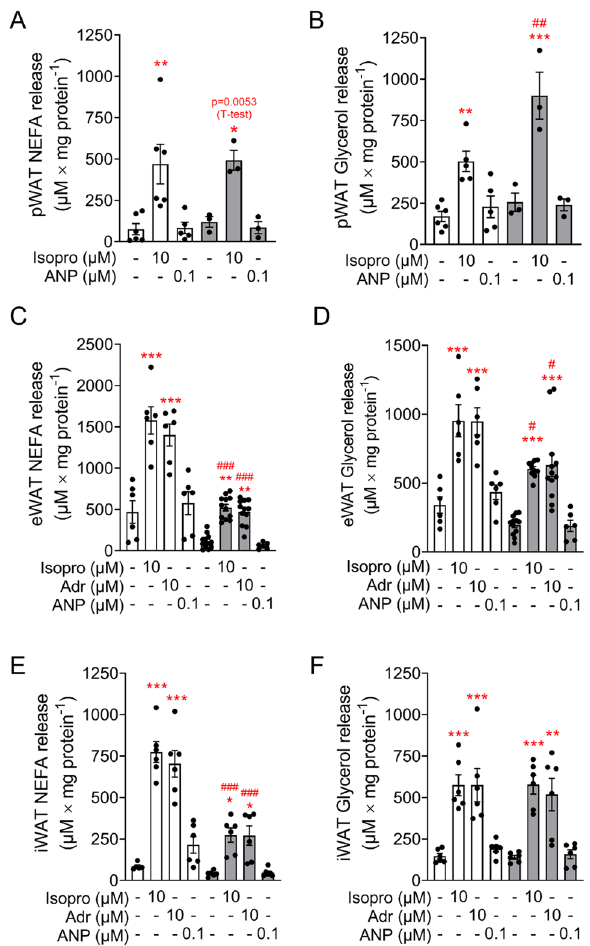
Figure 3. Isoproterenol stimulates lipolysis in adipose tissue. ( A , B ) pWAT, ( C , D ) eWAT and ( E , F ) iWAT pads from CD (white bars) and HFD (grey bars) mice were isolated and incubated as described under Material and methods. ( A , C , E ) Fatty acids release and ( B , D , F ) glycerol release in response to isoproterenol (Isopro), atrial natriuretic peptide (ANP) and adrenaline (Adr) are expressed as means ± SEM of n = 3–6 independent observation.** p < 0.01, *** p < 0.001 denotes significant stimulation vs the respective control; # p < 0.05, ## p < 0.01, ### p < 0.001 denotes a significant diet effect at the same